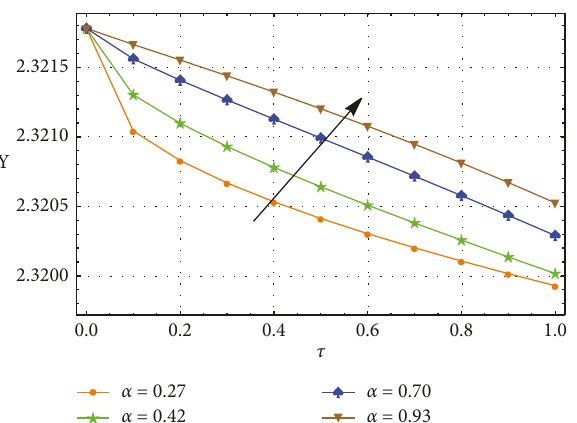
Figure 3: Evaluation of water surface level in Example 1 at different values of α with ρ � σ � 1, ] � 0.6 and x � 10.